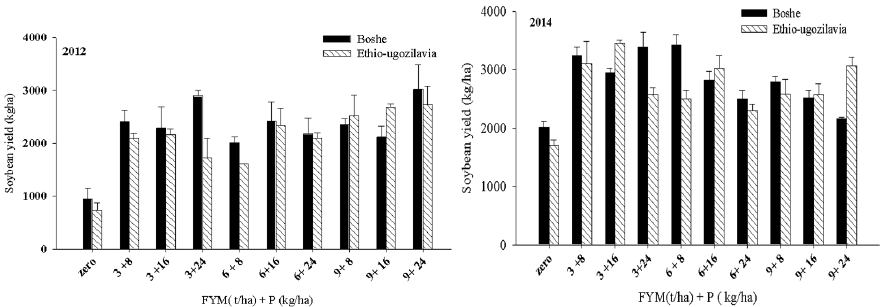
Figure 4. Effect of combined applications of different rates of FYM and phosphorus fertilizer on the yield of soybean varieties in the 2012 (left) and 2014 (right) cropping seasons at Bako, Ethiopia.